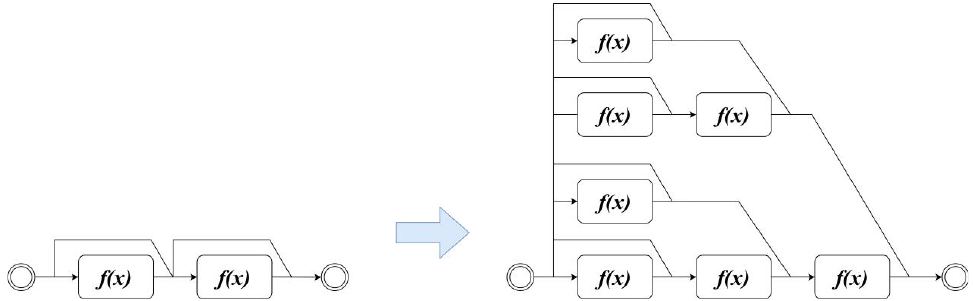
Figure 3. Expansion of the residual structure.